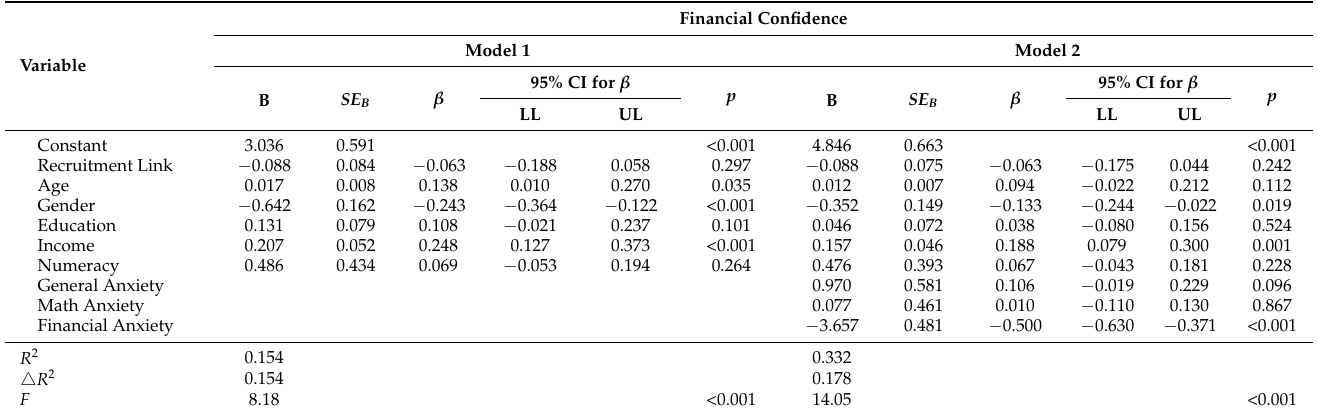
Table 3. Multiple Regression Assessing Factors Related to Financial